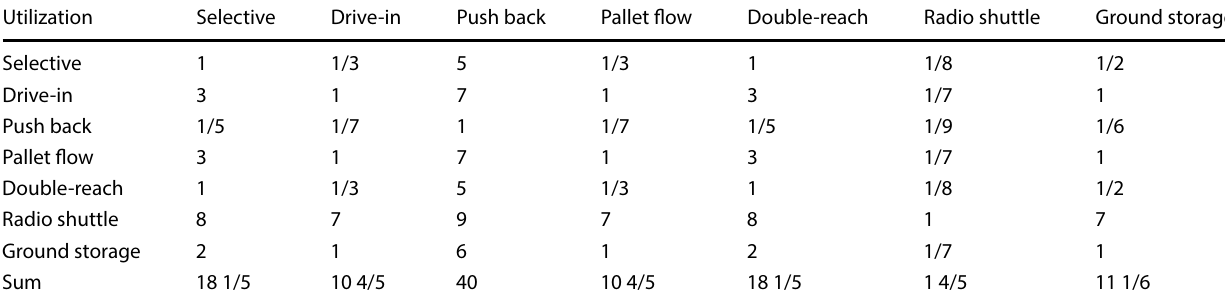
Table 10 Comparison between the alternatives in term of utilization